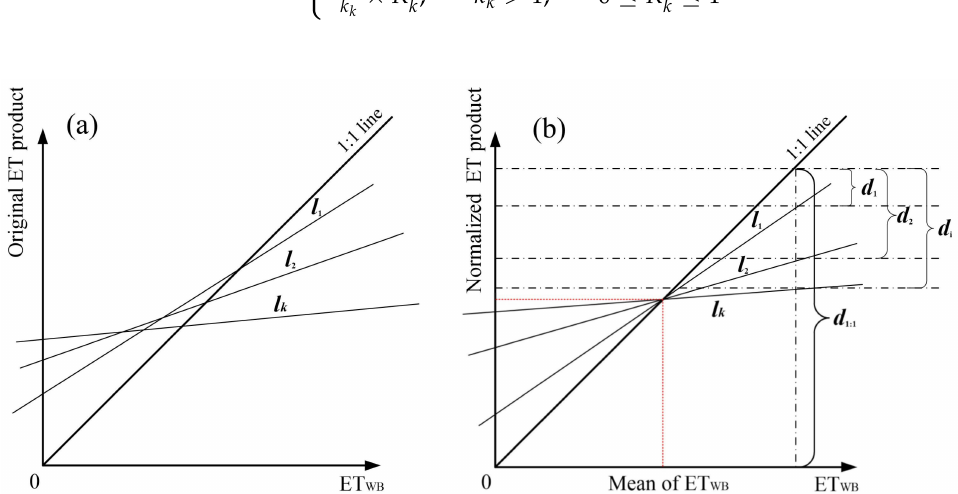
Figure 3. Schematic diagram of the weight calculations for different ET product. ( a ) l k refers to the regression line between the ET WB ( x axis) and original ET estimates ( y axis) of each product, ( b ) l k refers to the regression line between the ET WB ( x axis) and normalized ET ( y axis) of each product.